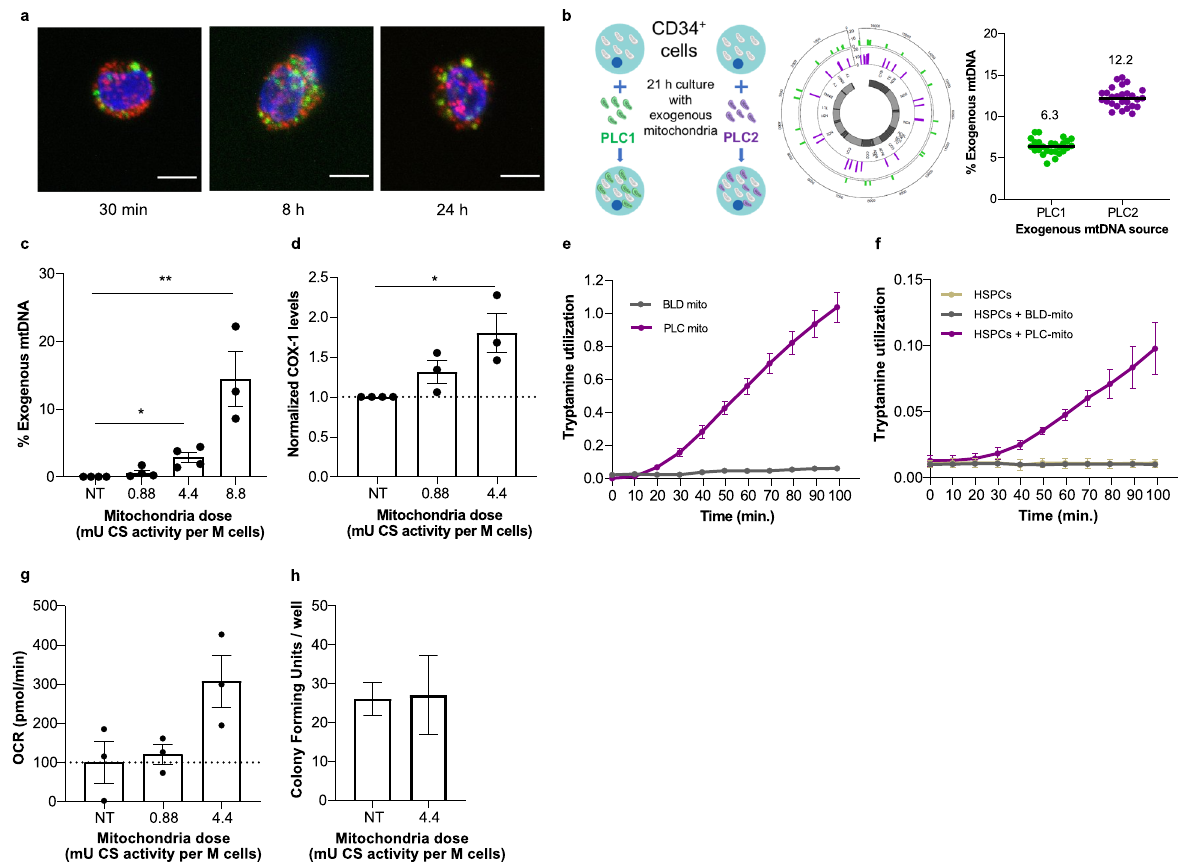
Fig. 1 Mitochondrial augmentation occurs in human HSPCs and is a dose-dependent process. a Representative confocal microscopy images of human CD34 + stained with MitoTracker Orange and subsequently augmented with GFP-labeled mitochondria isolated from HeLa cells. Images were taken at 30 min, 8 h, and 24 h post augmentation; scale bar, 5 µm. Mitochondrial dose used was 4.4 mU CS activity per million cells. b – d Healthy donor CD34 + cells were augmented for 21 h with increasing doses of placenta-derived mitochondria. b Illustration of method of assessing percent of exogenous mtDNA content using NGS. Single nucleotide variants which differentiate between donor and recipient cell mtDNA are identi fi ed, and percent representation of donor mtDNA variants ((placenta-derived mitochondria batch 1 (PLC1) or